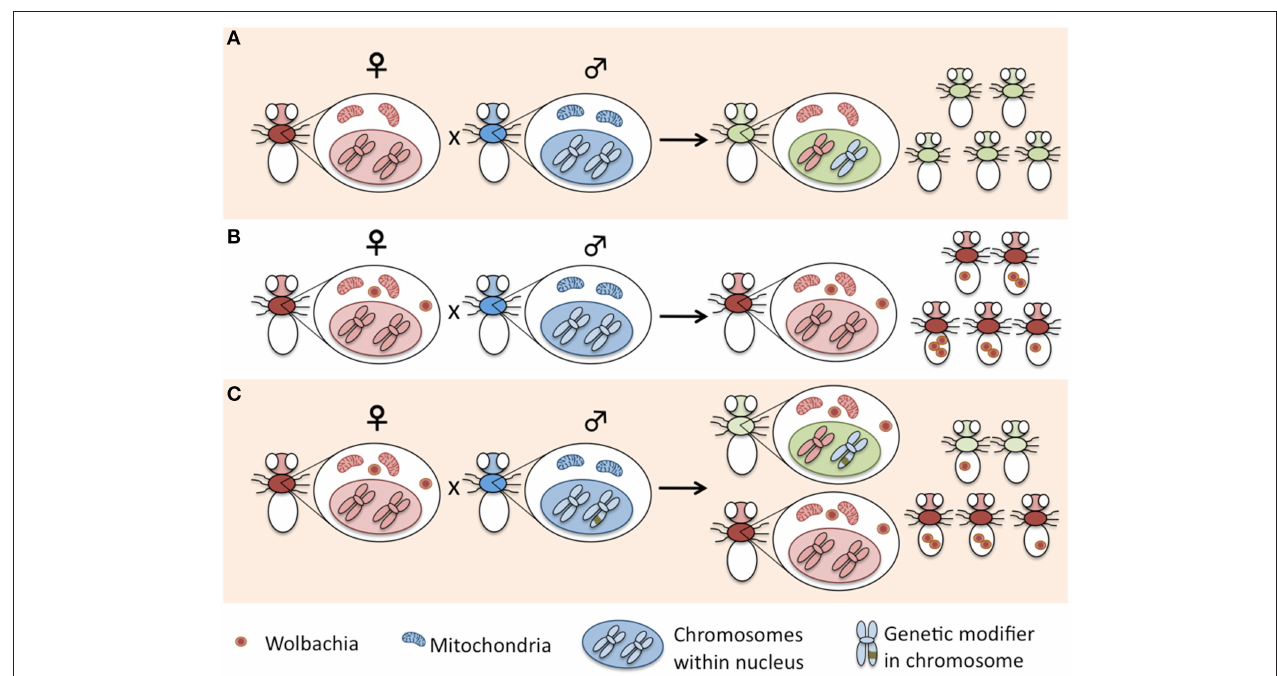
FIGURE 1 | Reproductive-manipulator Wolbachia are selfish genetic elements in conflict with the host nuclear genome, as the disproportionate spread of Wolbachia adversely affects the inheritance of not-linked host genes. Selection on those genomic regions would therefore favor genetic modifiers that counteract the effects of the cytoplasmic selfish element. The figure is a cartoon representation of a sex-distorter Wolbachia in a generic insect population. (A) In a non-infected population, males and females pass on their nuclear genetic material. (B) Wolbachia disproportionately affect the spread of infected female’s genes, rendering males less likely to pass their genetic material to the next generation. (C) As males become rare, those with genotypes that lower or suppress the sex-distortion phenotypes would have an increased reproductive success. Consequently, genes that supress or modify the sex-distortion would become common in the